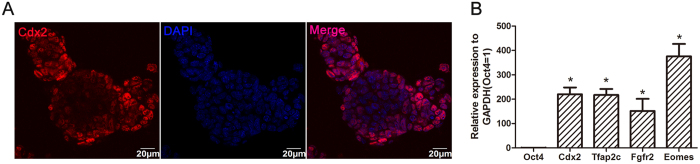
Characterization of TSCs and MSCs.(A) TSCs expressed the specific marker, Cdx2, by immunofluorescent staining. (B) TSCs expressed markers of Cdx2, Tfap2c, Fgfr2, and Eomes by RT-PCR, but did not express Oct4 (*P < 0.01). Data are represented as mean ± SD.